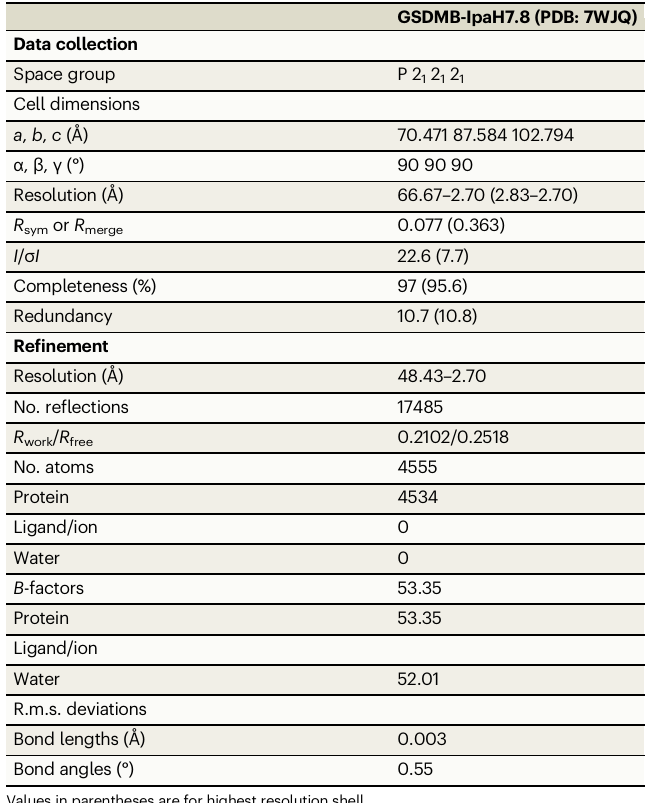
Table 1 | X-ray diffraction and re fi nement